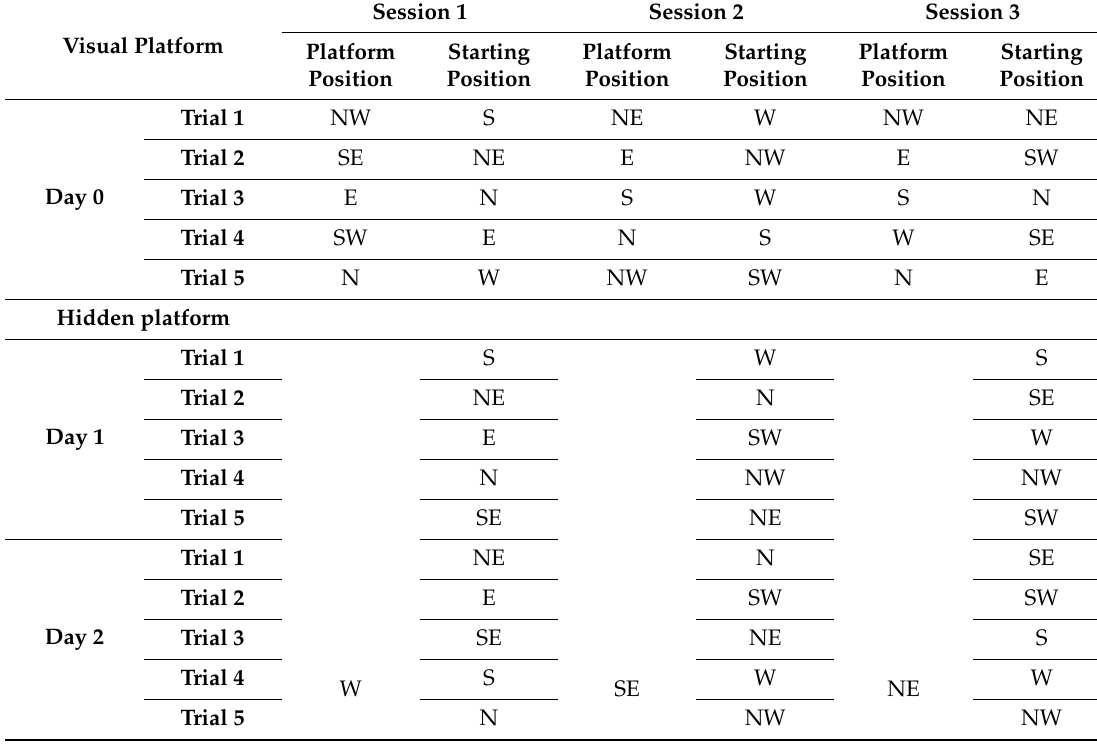
Table A1. Randomization of platform and starting positions in the Morris water maze task during the three sessions of behavior